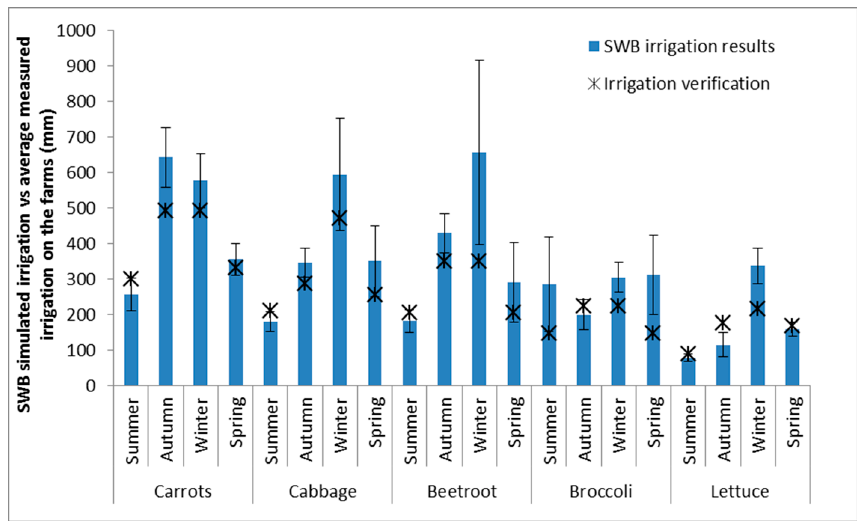
Figure 4. Average of 10 years’ simulated seasonal irrigation (2004–2013) with standard deviations (shown as error bars) of vegetable crops in the different growing seasons compared to measured irrigation verification data from farms on the Steenkoppies Aquifer.